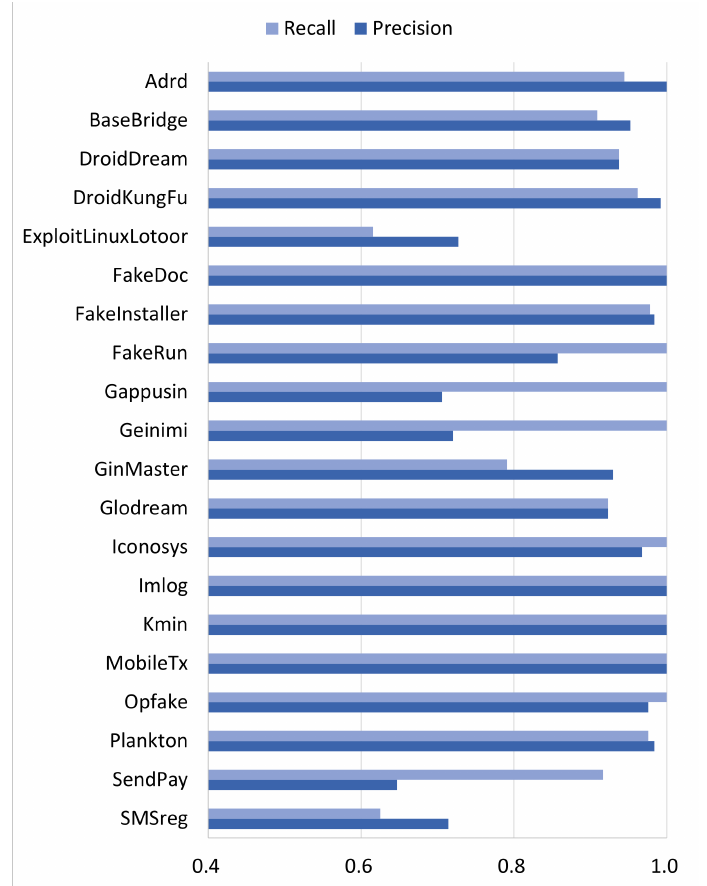
Figure 9. Family-level performance of LightGBM for permission set